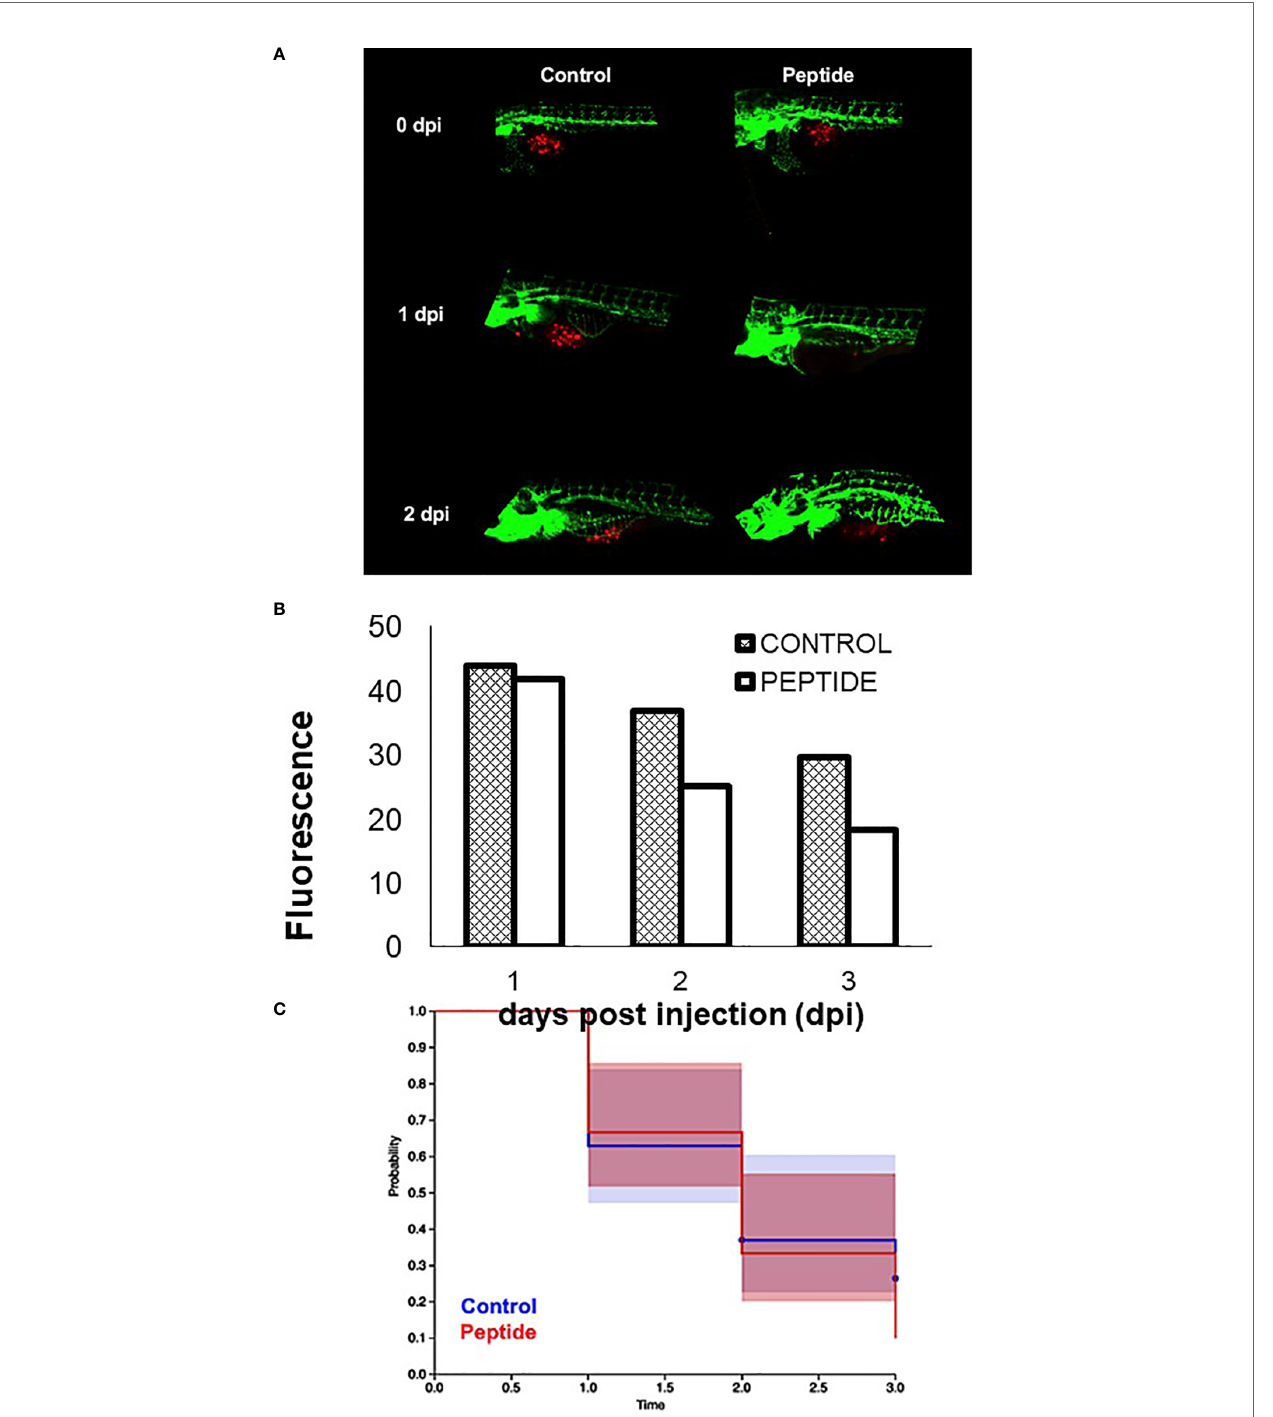
FIGURE 8 | Effect of HS-binding peptide on tumor progression. Approximately 150 PDX cells obtained by surgical resection of a patient with triple-negative breast cancer were labeled with red fl uorescent protein (RFP) and injected into the zebra fi sh embryo yolk sac after 1 day of fertilization (1 dpf). Embryos were incubated for 18 hours, 35.5°C. Peptide, animals were treated with 10 µM HS-binding peptide. Control, animals were not treated. Green; green fl uorescent protein (GFP) labeled blood vessels. Red; red fl uorescent protein (RFP) labeled tumor cells. (A) Representative images of the control group and the treated group. (B) Quanti fi cation of tumor fl uorescence (tumor size). The bar represent the average of red fl uorescence in zebra fi sh embryos. (C) Values express percent survival of animals; red line (10 m M of peptide treatment); blue line (animals in the absence of treatment). Each group contains 10 zebra fi sh embryos. Peptide decreased the number of tumoral cells and increased